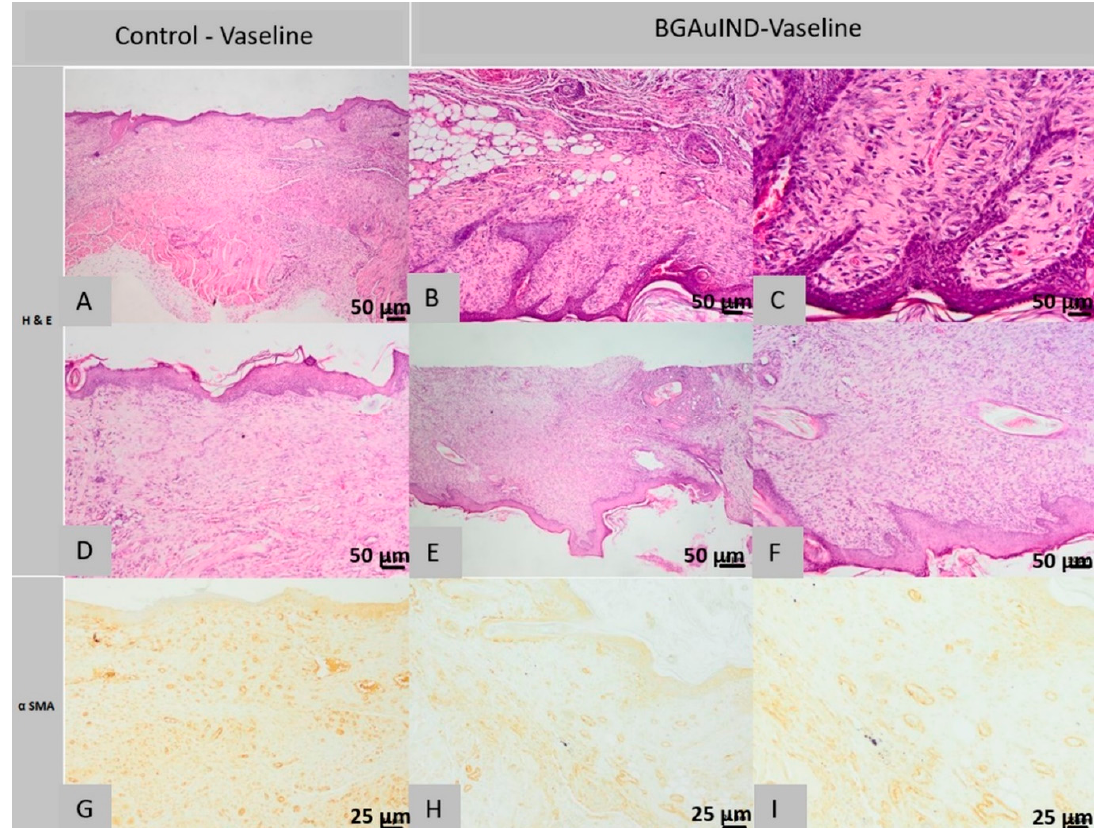
Figure 12. Histopathological images of the skin and subcutaneous tissue from the control animals from group BGAuIND- Vaseline: completely healed surgical wound, absent pilosebaceous glands ( A ), excess granulation tissue with fusiform cells, most myofibroblasts ( A ) and ( D ), (HE column, ob. 40×) epidermis, focal, discontinuous ( G ), excess granulation with myofibroblasts ( G ) (col. α SMA ob. 40×) Histopathological images of the skin and subcutaneous tissue from the animals treated with BGAuIND-Vaseline: completely healed surgical wound, partially regenerated pilosebaceous units ( B , C ), scar tissue with rare myofibers ( E ), completely healed surgical wound ( F ), (HE column, 40× ob.) excess granulation tissue, partially oriented ( H ), scar tissue with rare myofibrils ( I ) (col. α SMA ob. 40× This section may be divided by subheadings. It should provide a concise and precise description of the experimental results, their interpretation as well as the experimental conclusions that can be